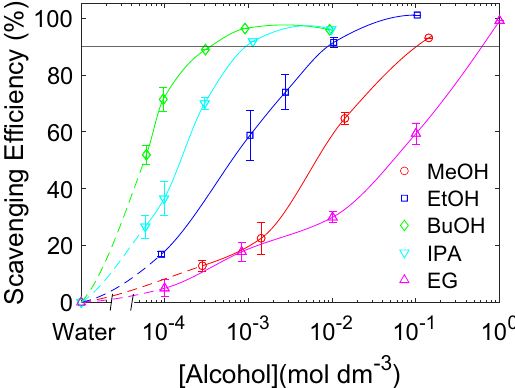
Figure 2. Scavenging efficiency of · OH radicals as a function of alcohol concentration. Methanol (MeOH) ( (cid:31) ), ethanol (EtOH) ( (cid:31) ), 1-butanol (BuOH) ( ♦ ), 2-propanol (IPA) ( ▽ ), and ethylene glycol (EG) ( △ ) were used as radical scavengers. Solid and dotted lines are drawn with spline interpolation to guide the eye. The horizontal line at 90% represents the upper detection limit for the scavenging